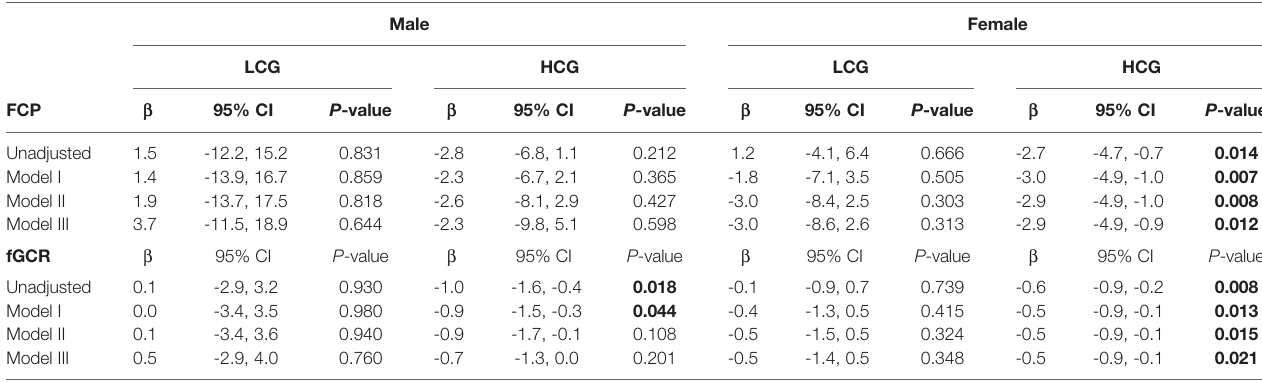
TABLE 4 | Logistic regression used to evaluate the association between 1-mg DST inhibition rate and glucose metabolism in men and women as strati fi ed by level of cortisol secretion. Male Female LCG HCG